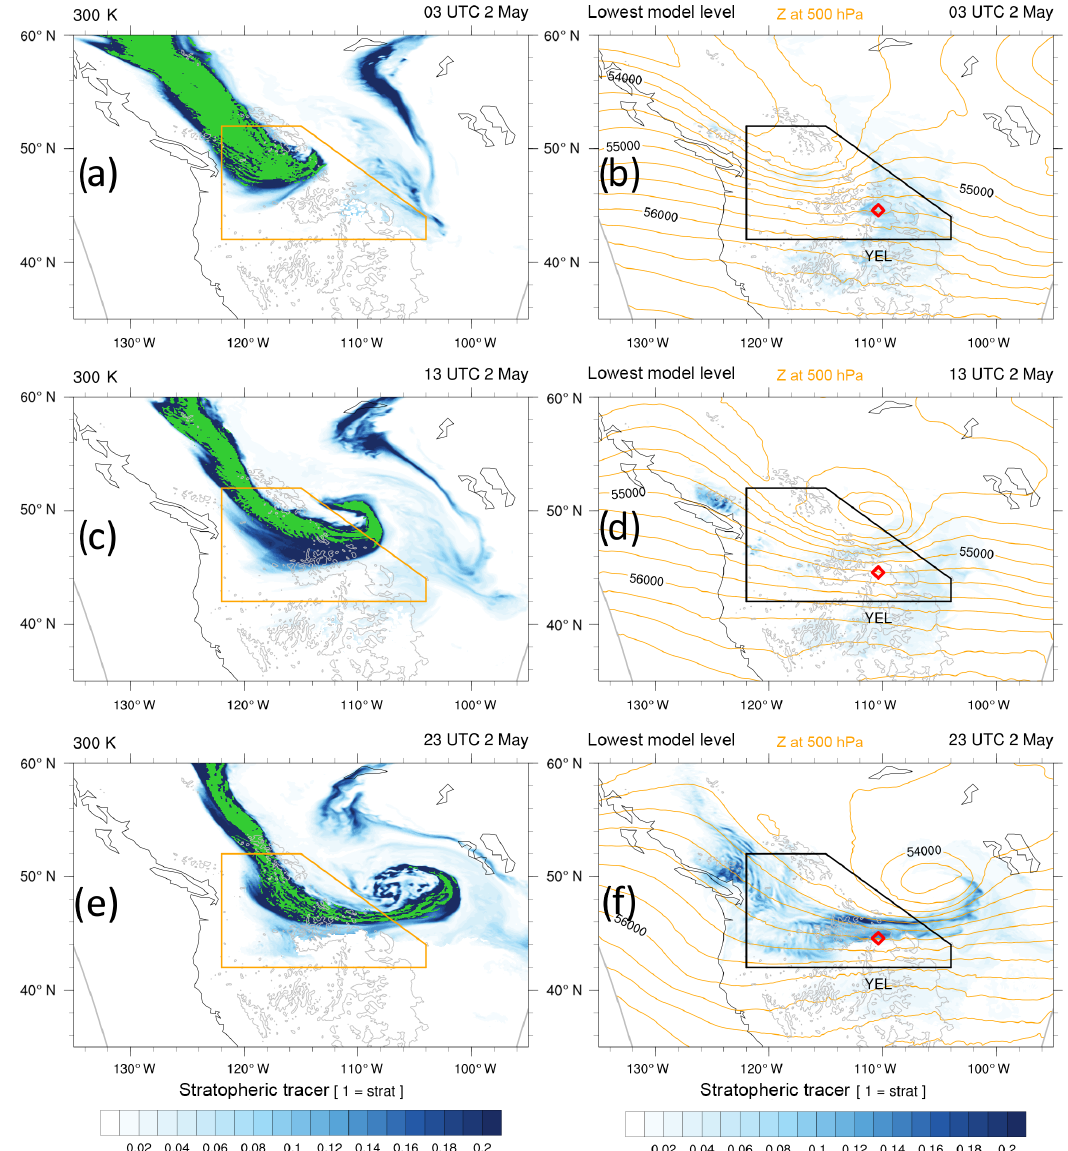
Figure 4. Concentration of stratospheric tracer (blue colours up to values of 0.2; green shows values larger than 0.5) on the 300K isentrope (left) at (a) 03:00UTC on 2 May, (c) 13:00UTC on 2 May and (e) 23:00UTC on 2 May 2006 (as in Fig. 3) and (right) on the lowest model level at the same times. Additionally, the geopotential height at 500hPa is shown with orange contours (contour interval 250m) in panels (b) , (d) and (f)